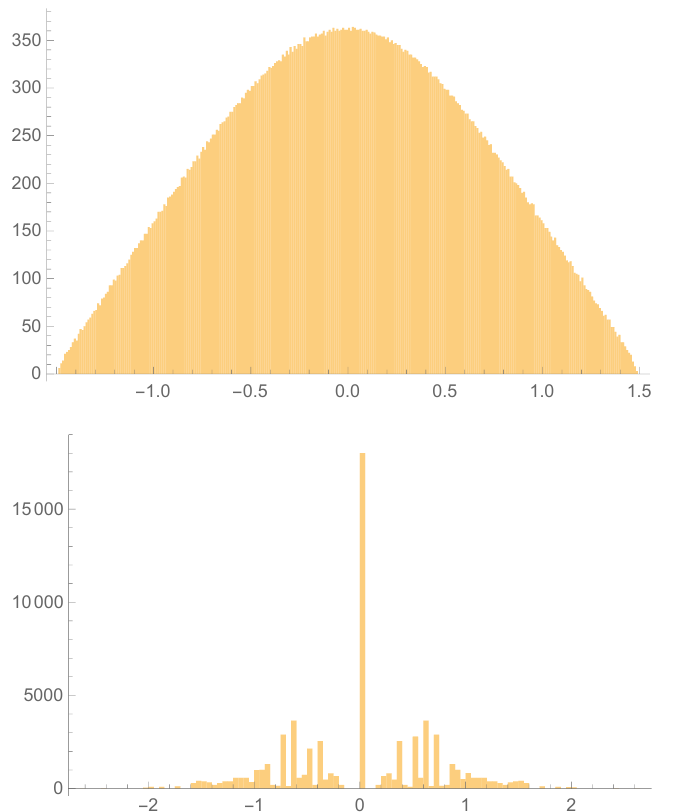
Figure 4 . Top: the SYK spectrum. Bottom: the GW model